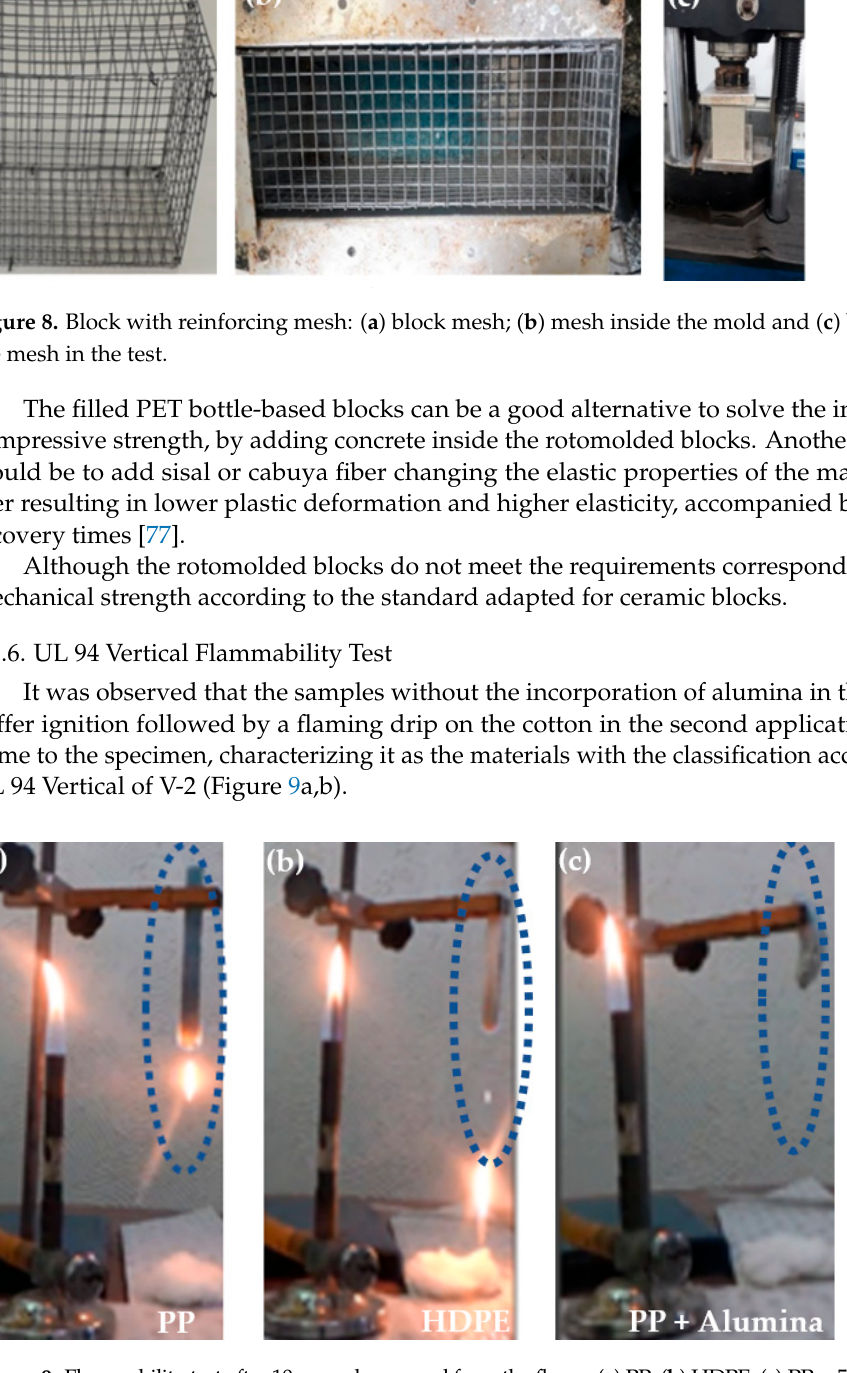
Figure 9. Flammability test after 10 seconds removal from the flame: ( a ) PP; ( b ) HDPE; ( c ) PP + 5% alumina.